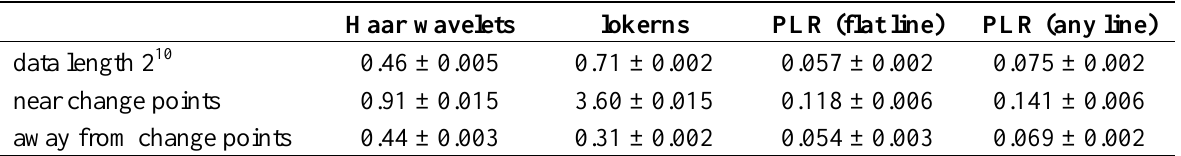
Table 2. The RMSE of smoothed data. PLR is piecewise linear regression and lokerns is local kernel smoothing. Notice that wavelet smoothing does better than lokerns near the change points. The “any line” option of PLR is the most relevant for SM